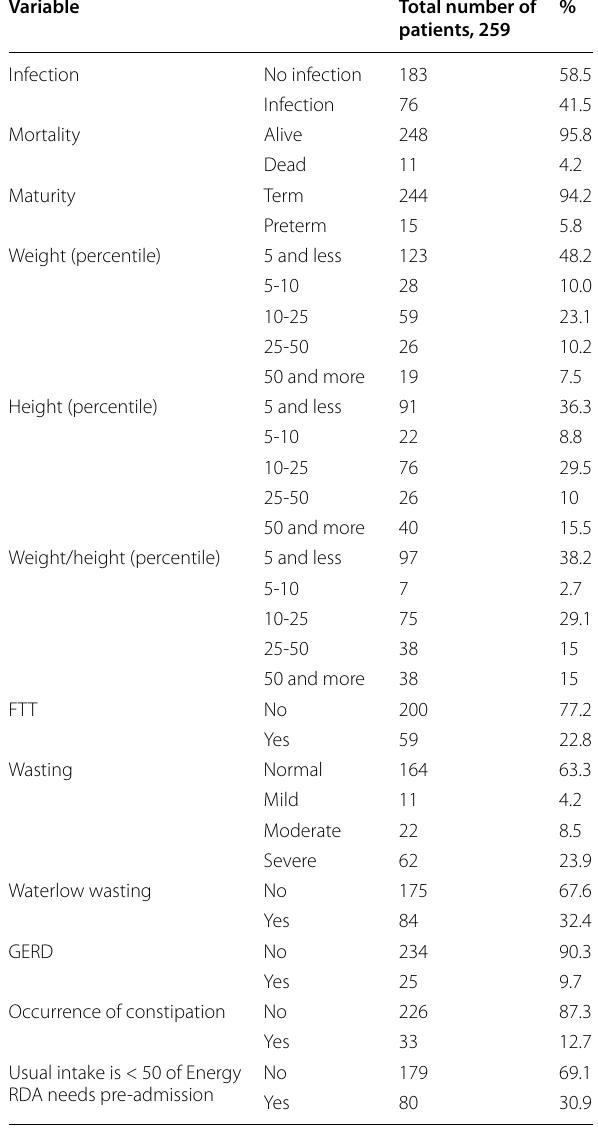
N number, FTT failure to thrive, GERD gastroesophageal reflux disease